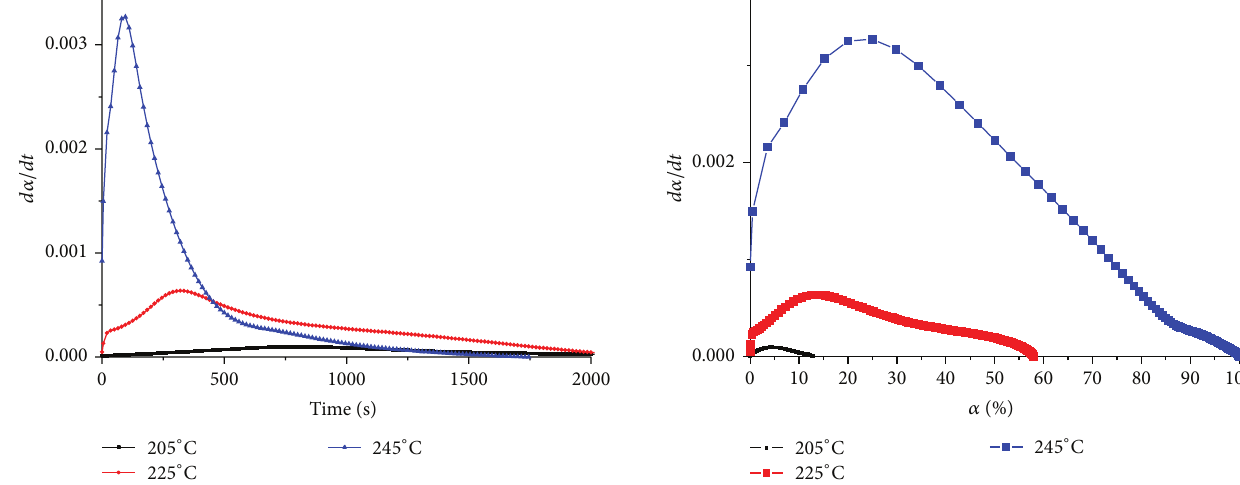
Figure 3: 𝑑𝛼/𝑑𝑡 versus time of BZ/F-51 hybrid networks in isother- mal DSC.